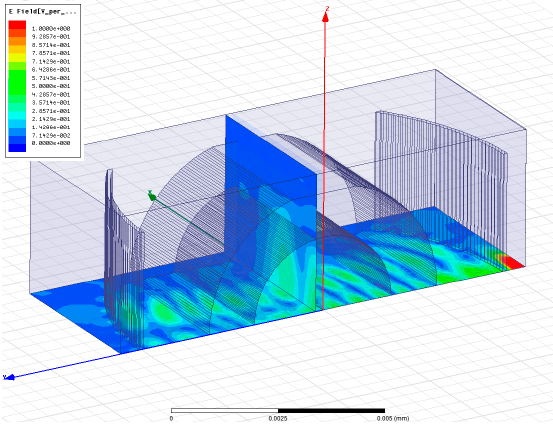
Figure 7. The electric field distribution of higher order resonance mode at 1542 nm for the test liquid n t = 1.3. Table 1. Comparison between the Q -factor and the confinement distance between different test liquid filling the tube.